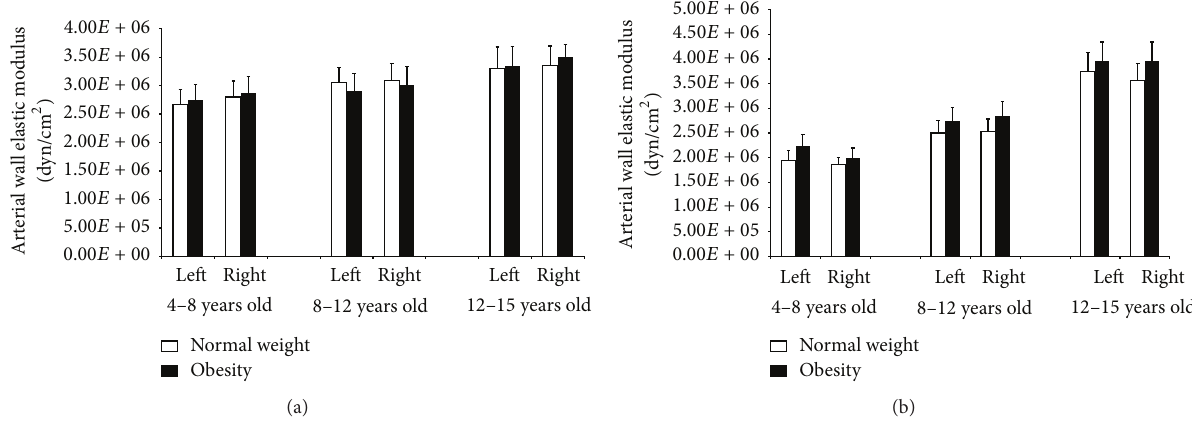
Figure 2: Common carotid (a) and femoral (b) arterial wall elastic modulus for normal weight and obese children and adolescents. There were no statistical differences between normal weight and obese arteries, when comparisons were done considering the same artery and hemibody (left or right), indicating that there were no significant intrinsic arterial wall elastic alterations associated with